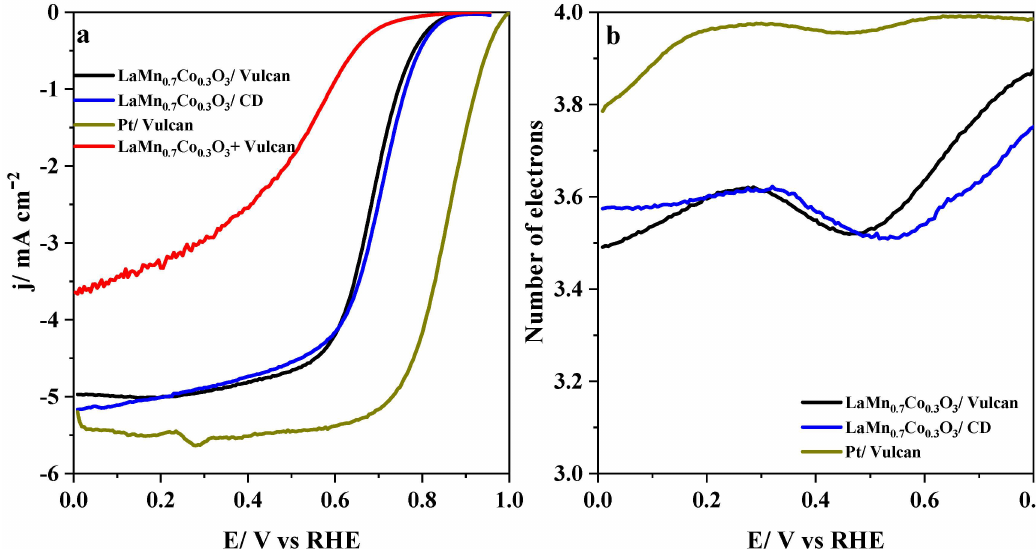
Figure 9. ( a ) Linear sweep voltammograms recorded at 1600 rpm on an RDE for a LaMn 0.7 Co 3 O 3 perovskite mixed with di ff erent carbon materials (1:1 mass ratio) in an agate mortar and the